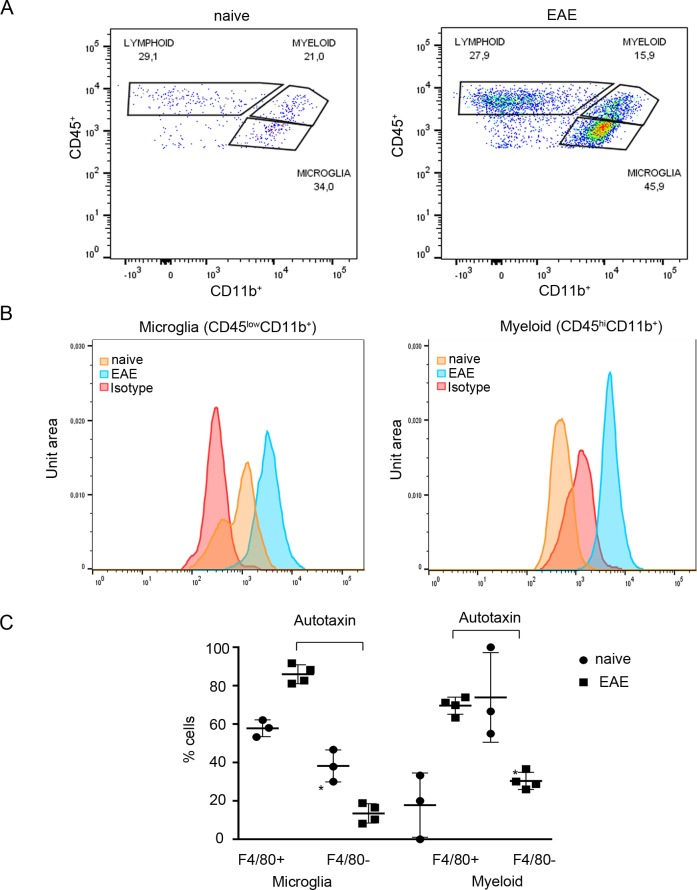
ATX is expressed by activated macrophages and microglia.Representative flow cytometry profile from spinal cord suspension prepared from naive and EAE mice. (A) CD45/CD11b FACs plot of EAE and naive mice following forward scatter and side scatter gating and doublets exclusion from CD45+ cells. lymphoid cells: CD45+CD11b-; microglia: CD45lowCD11b+; myeloid cells: CD45hiCD11b+. (B) Representative ATX expression in microglia and macrophages in EAE and naive mice and isotype staining control. (C) F4/80 expression in ATX expressing CD11b+ cells. Statistical significance between experimental groups was assessed with one-way ANOVA complemented with Bonferroni multiple pair test. * p<0.05.